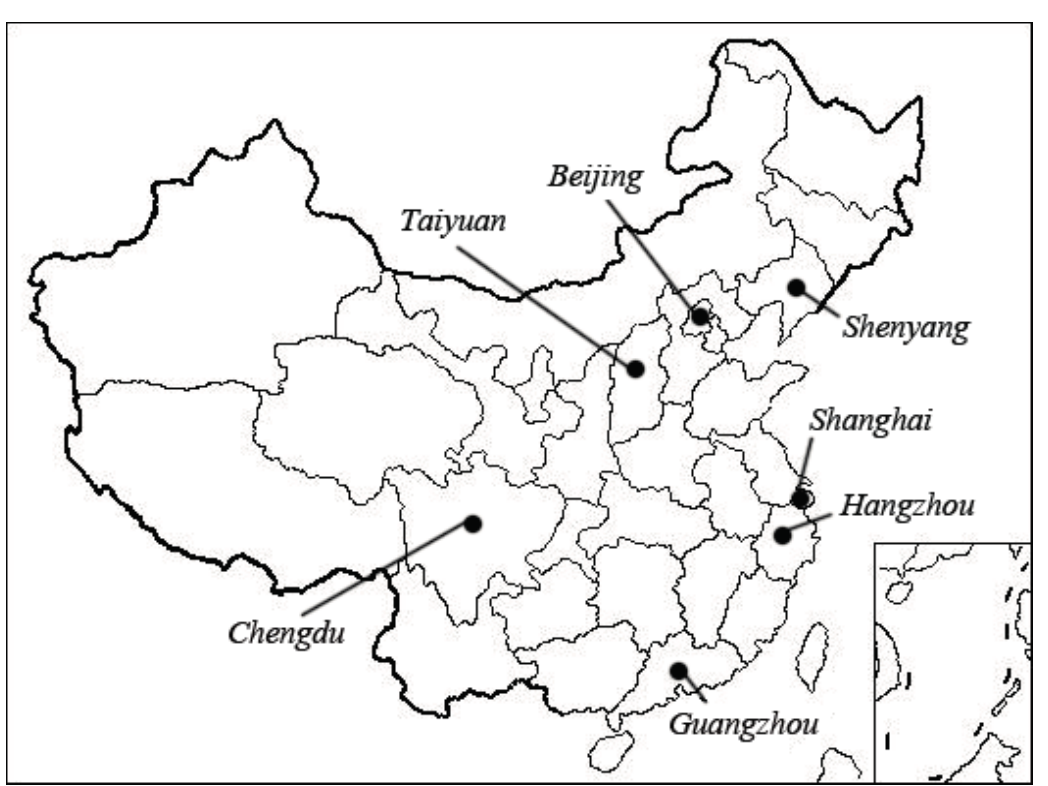
Figure 1. Locations of the recruitment in